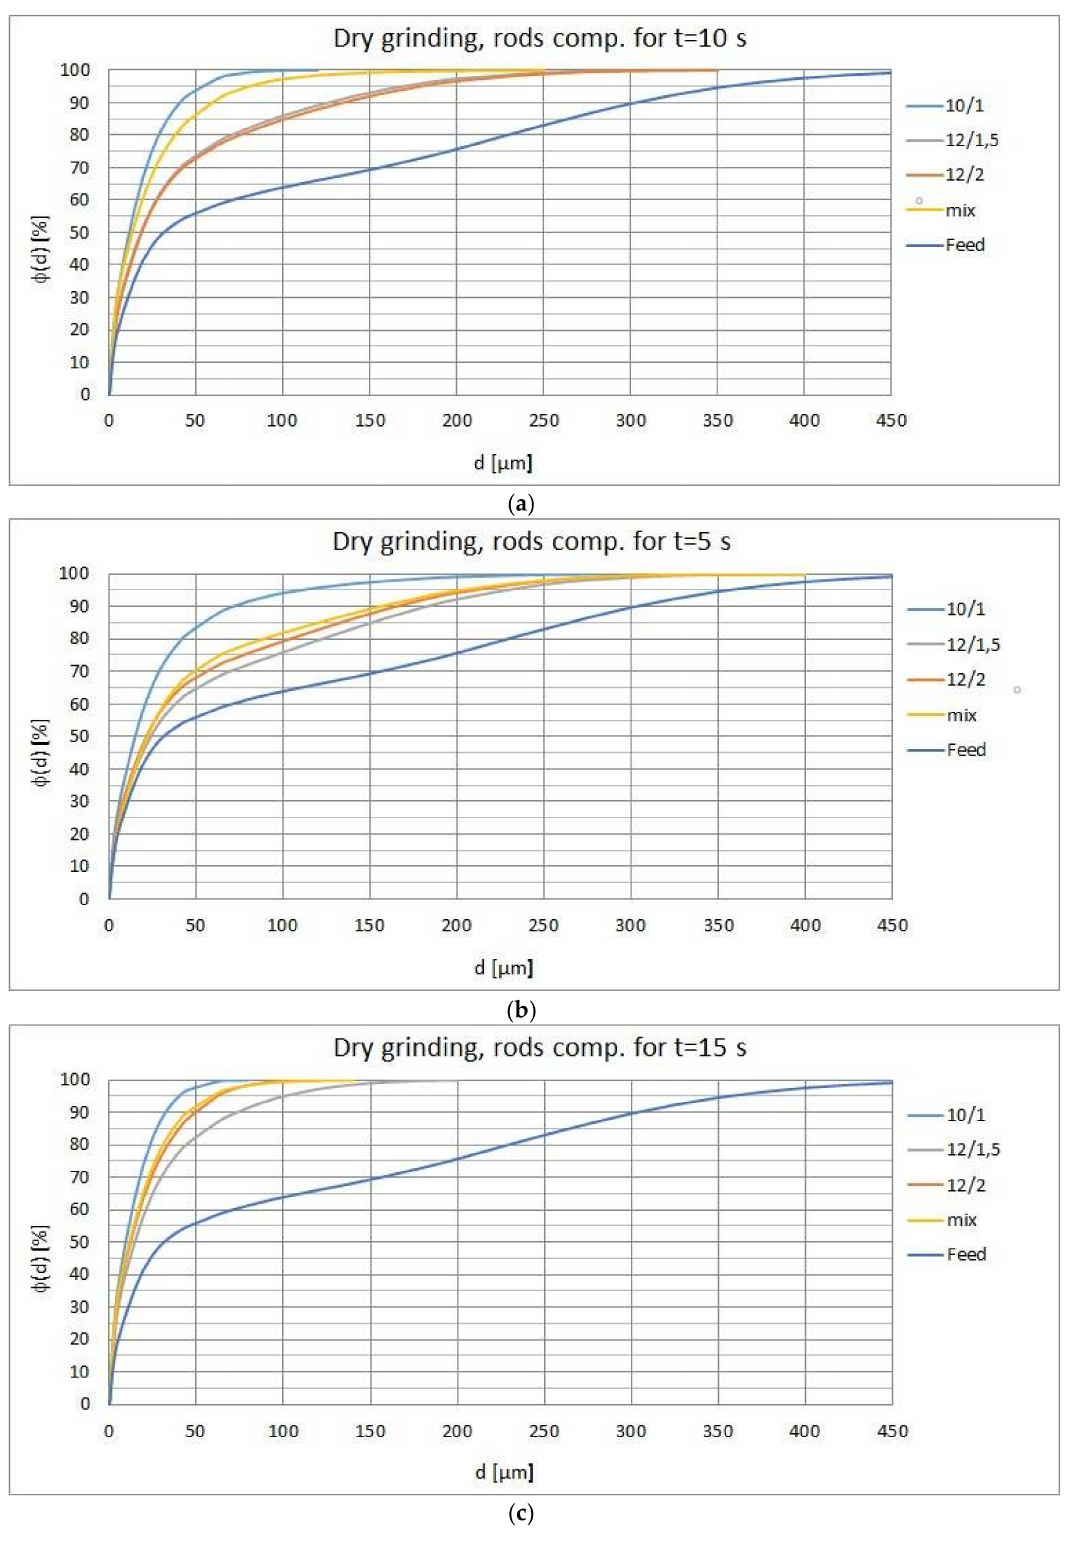
Figure 13. Comparison of cumulative volume curves for dry grinding with different rods: ( a ) 10 s; ( b ) 5 s and ( c ) 15 s of processing